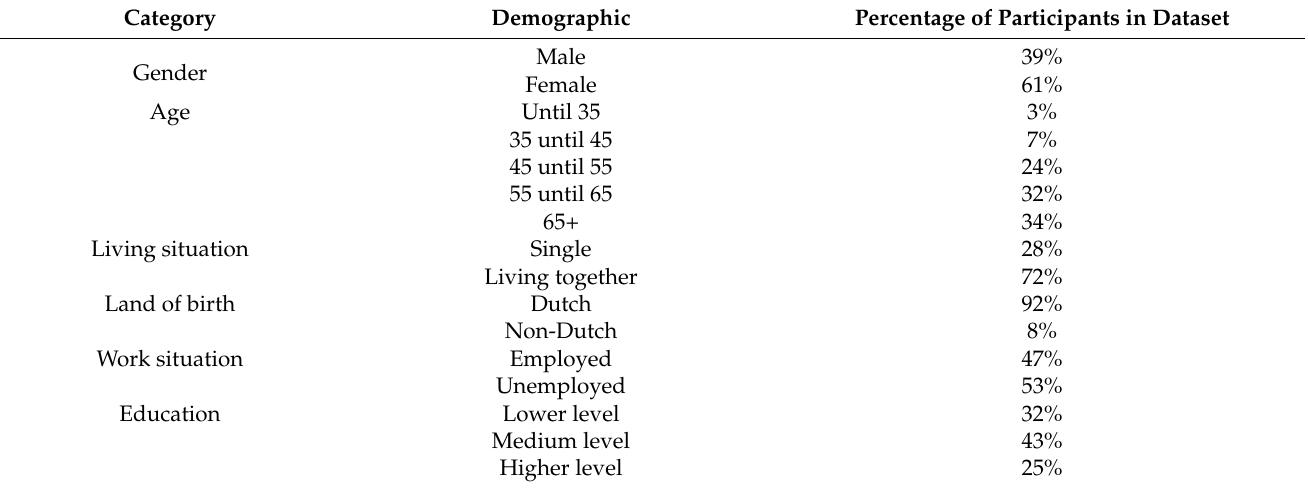
Table 1. Demographics of the participants at T0.